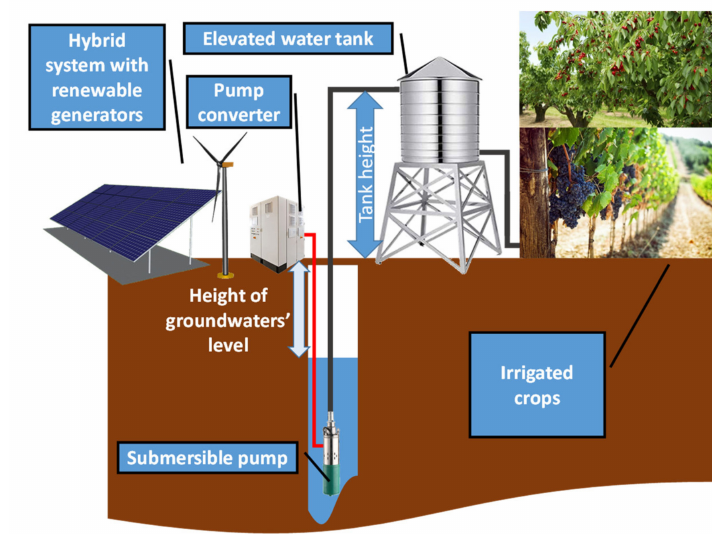
Figure 3. Illustration of the considered irrigation